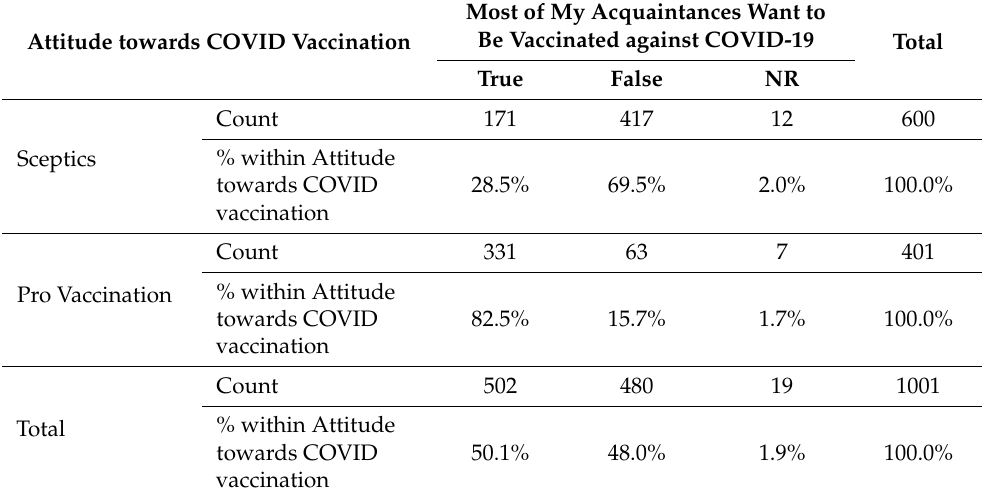
Table 9. Attitude towards COVID vaccination vs. Most of my acquaintances want to be vaccinated against